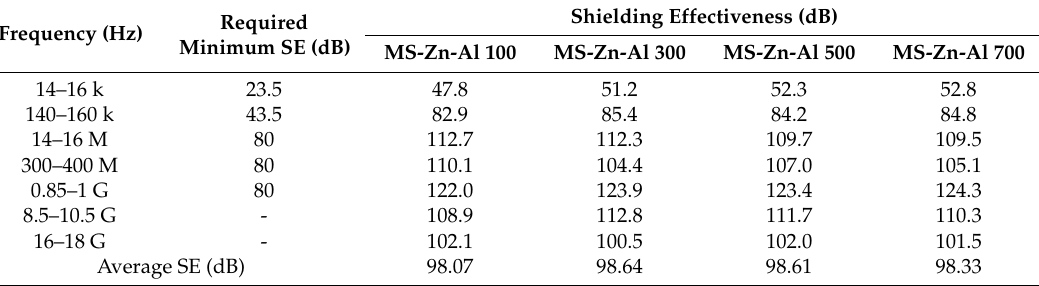
Table 4. SE test results of specimens 4–7.